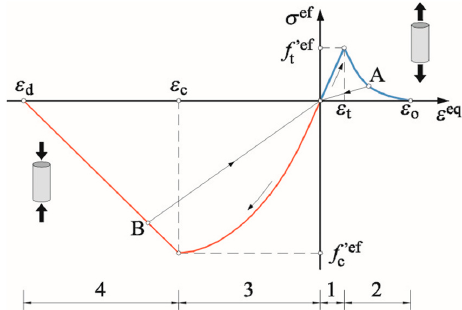
Figure 2. Equivalent uniaxial stress-strain relationship for elastic model with material degradation.